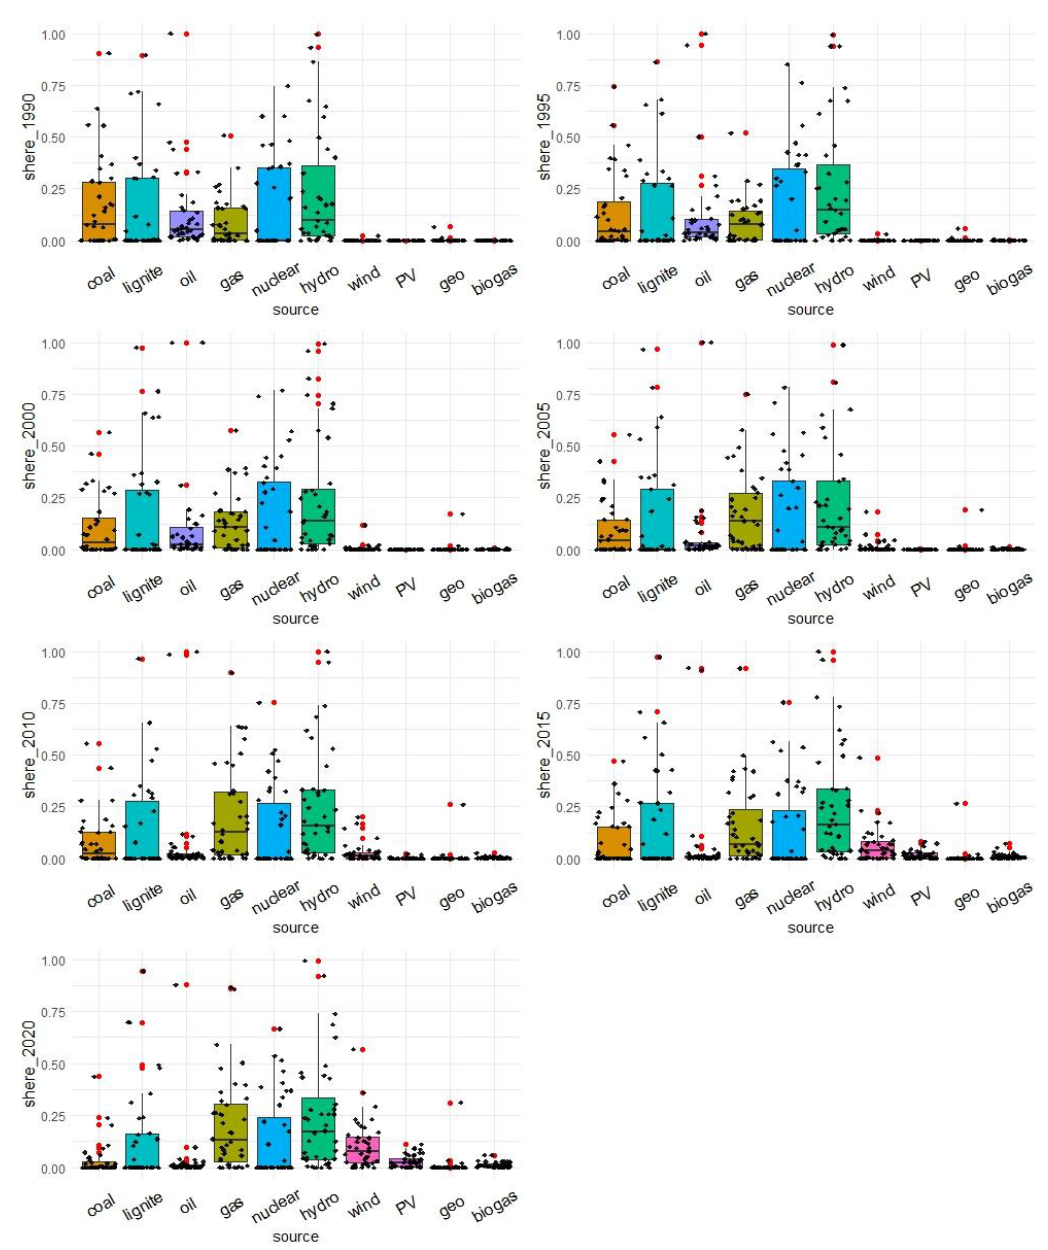
Figure 1. Changes in the structure of electricity production in Europe in the years 1990 – 2020.